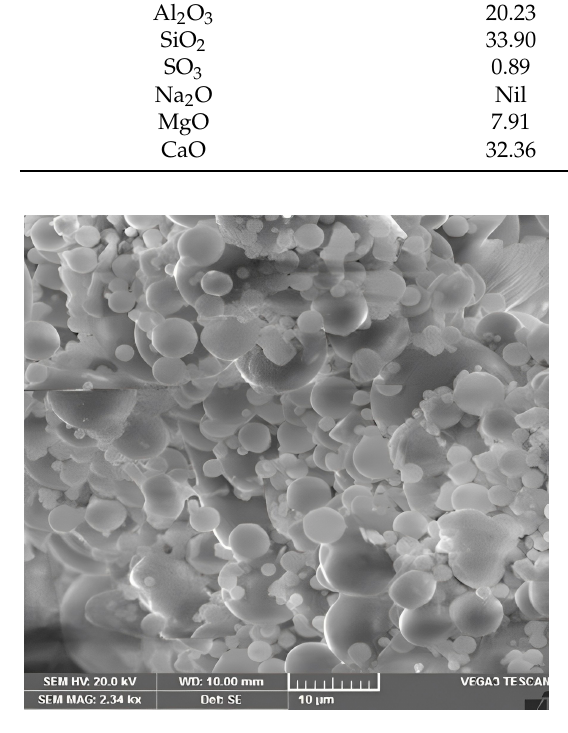
Figure 1. Picture shows fly ash SEM image.